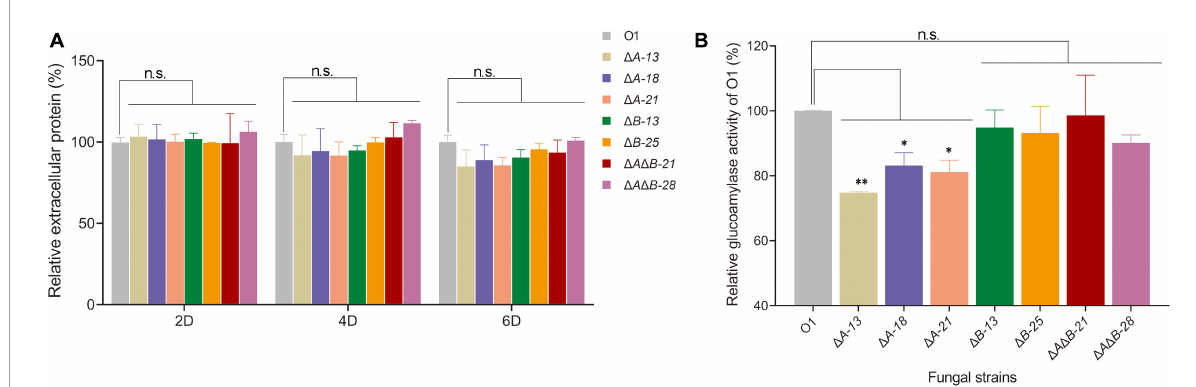
FIGURE1 Effects of agdA and/or agdB knockout (KO) on extracellular protein levels, glucoamylase activity. (A) Extracellular protein levels in supernatants of 2-day, 4-day, and 6-day shake-flask fermentation cultures of Aspergillus niger O1, agdA -KO strains, agdB -KO strains, and agdA / agdB double KO strains. Relative extracellular protein = extracellular protein level in supernatant of engineered strain compared with that in supernatant of strain O1. (B) Glucoamylase activity assay in supernatants of 6-day shake-flask fermentation cultures of A. niger O1, agdA -KO strains, agdB -KO strains, and agdA / agdB double KO strains. Relative glucoamylase activity = glucoamylase activity in supernatant of engineered strain compared with that in supernatant of strain O1. Values are means ± SD ( n = 3 repeats). ∗∗ P < 0.01 (Student’s t -test), ∗ P < 0.05 (Student’s t -test), n.s., not